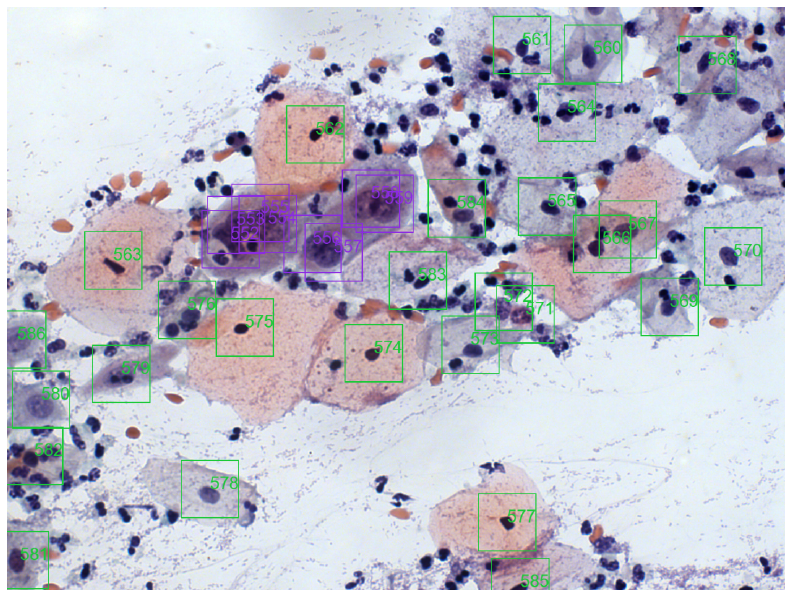
Figure 3. Image example from the cervical cell classification